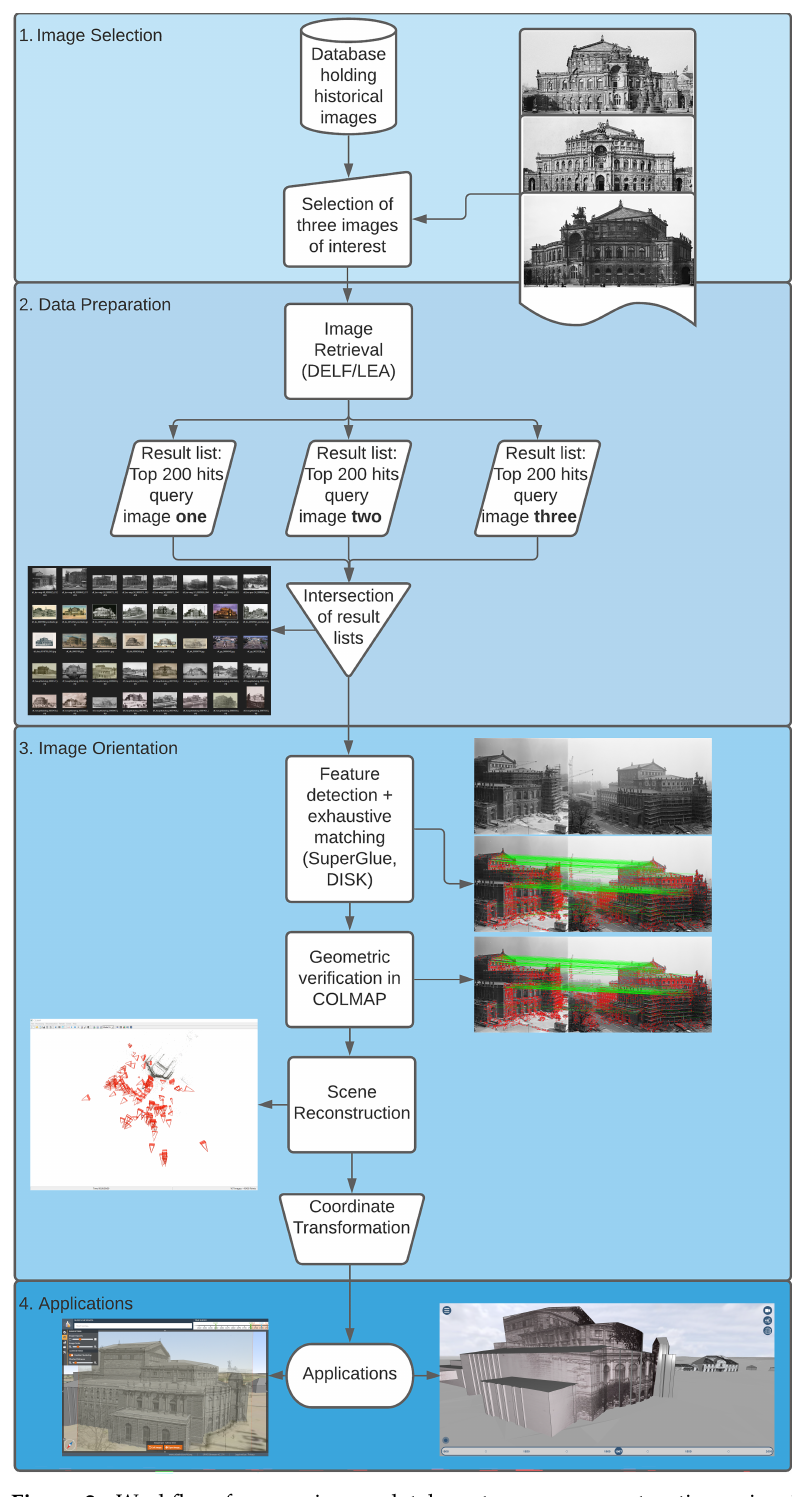
Figure 2. Workflow from an image database to scene reconstruction using image retrieval and photogrammetric